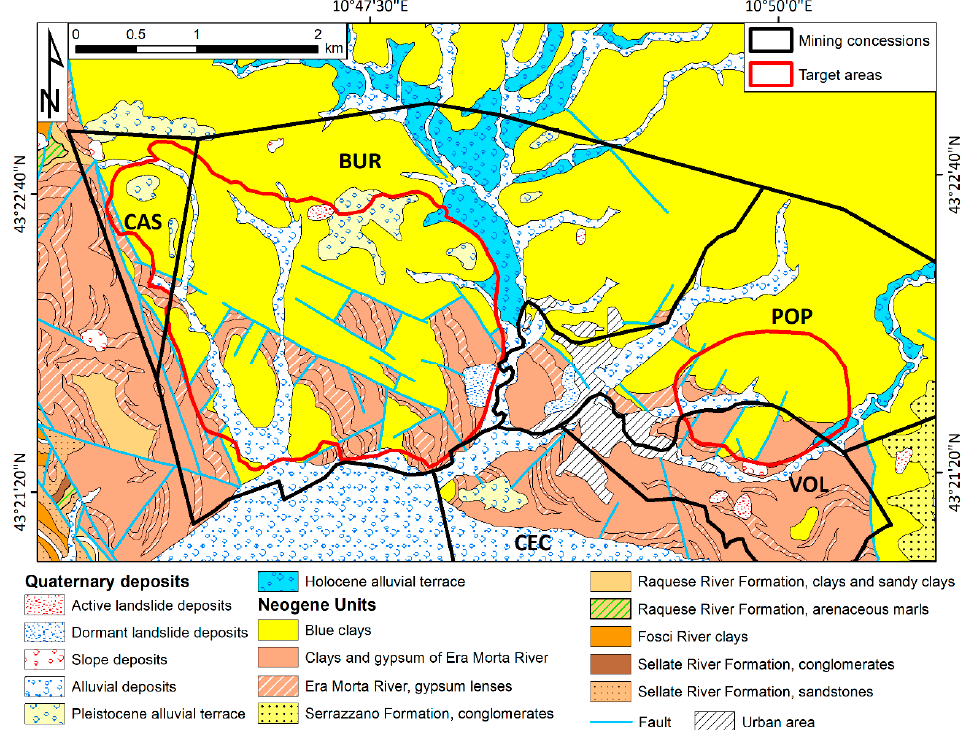
Figure 2. Geological map of the study area. From the Geological Map of Italy, 1:50.000 scale, Sheet 295-Pomarance